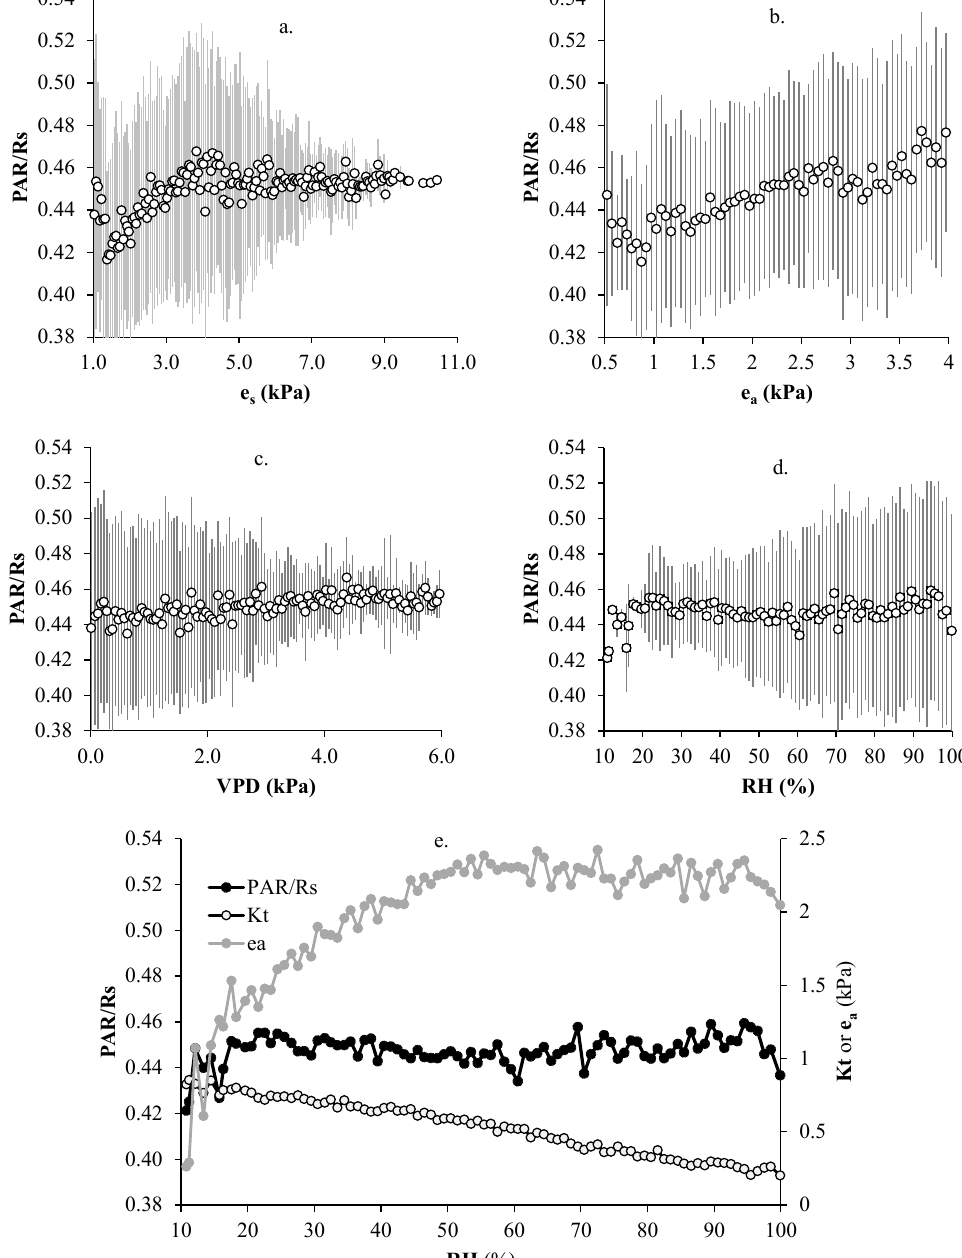
Figure 9. Averages and standard deviations of the PAR/Rs hourly ratio with the variation of ( a ) saturation vapor pressure e s , ( b ) actual vapor pressure e a, and ( c ) vapor pressure deficit VPD grouped in 0.05 bin-classes and also with ( d ) relative humidity grouped in 1% bin-classes. The comparative changes of PAR/Rs with RH is also presented ( e ) in association with the respective values of e a and K t per 1% RH bin-classes.